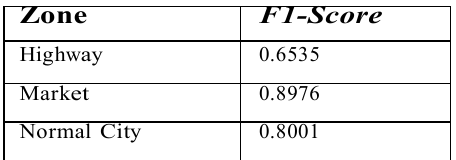
Table 11. Zonewise Accuracy of GB Classifier.